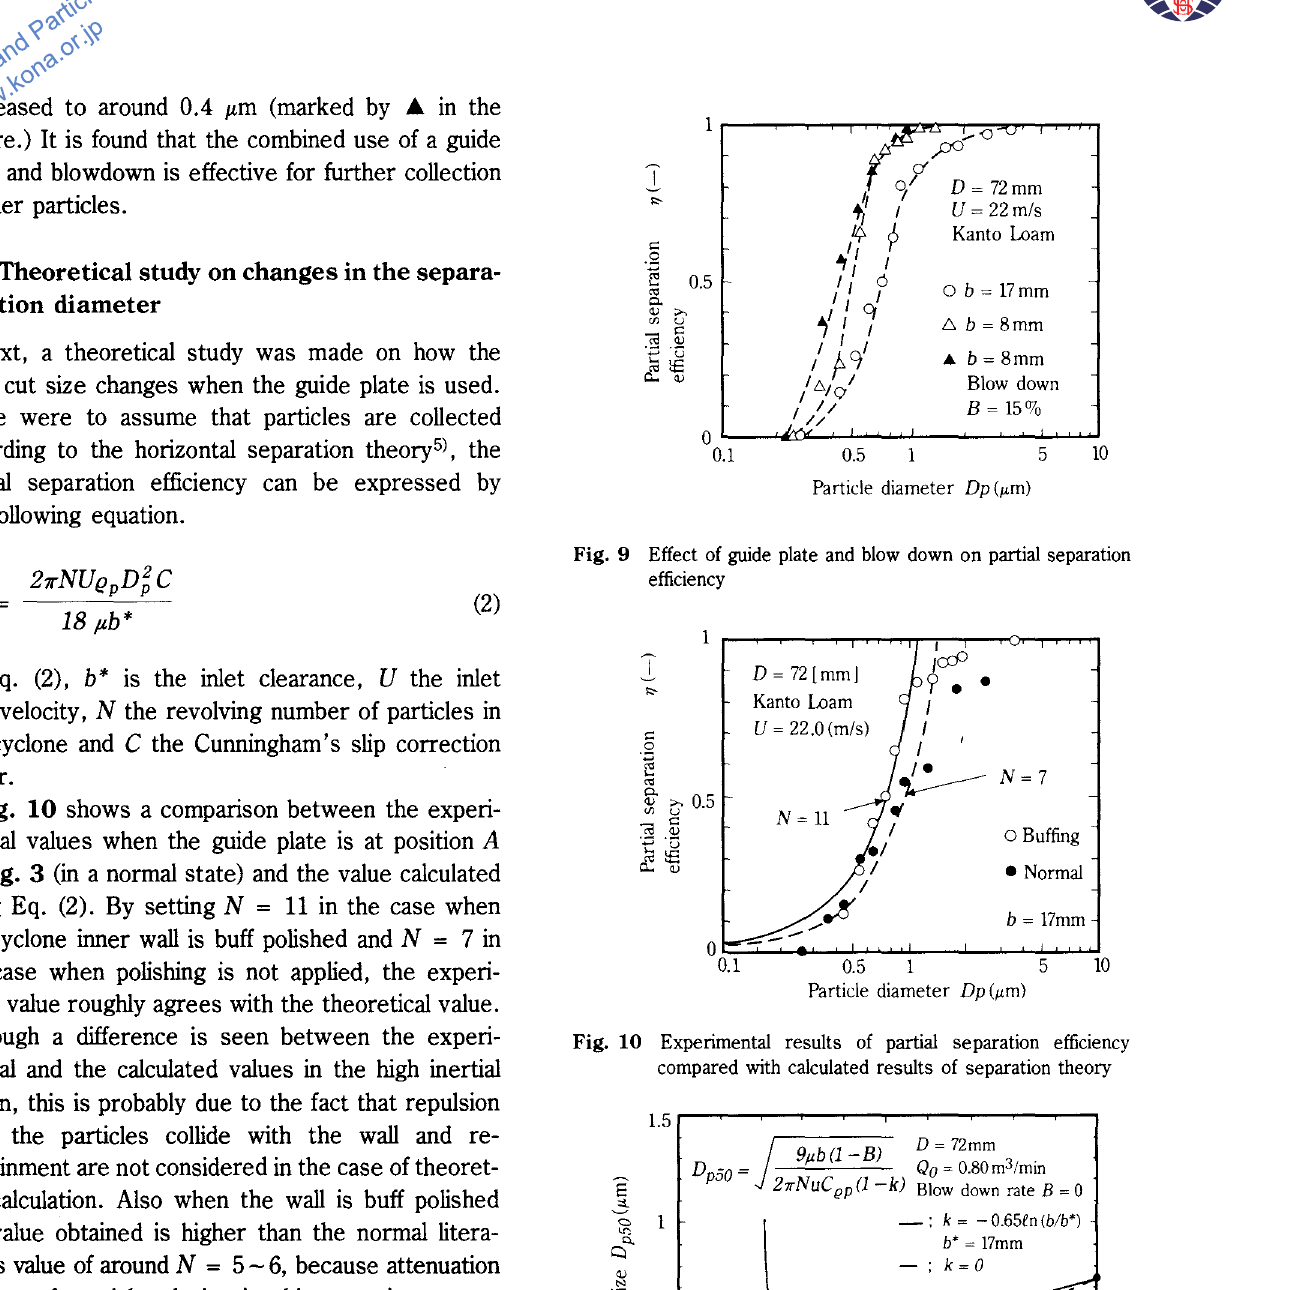
Fig. 11 Change of 50o/o cut size with inlet clearance of guide plate However when the guide plate is used, calculation was made with U, b* of Eq. (2) converted to u,